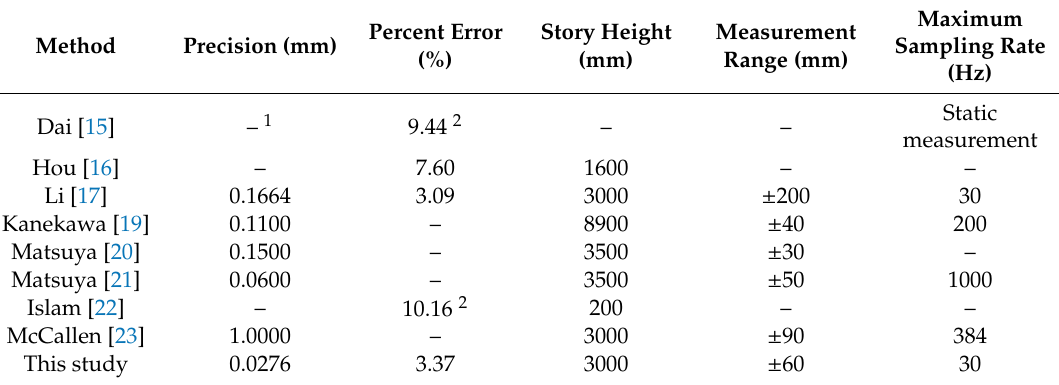
Table 5. The parameters of di ff erent